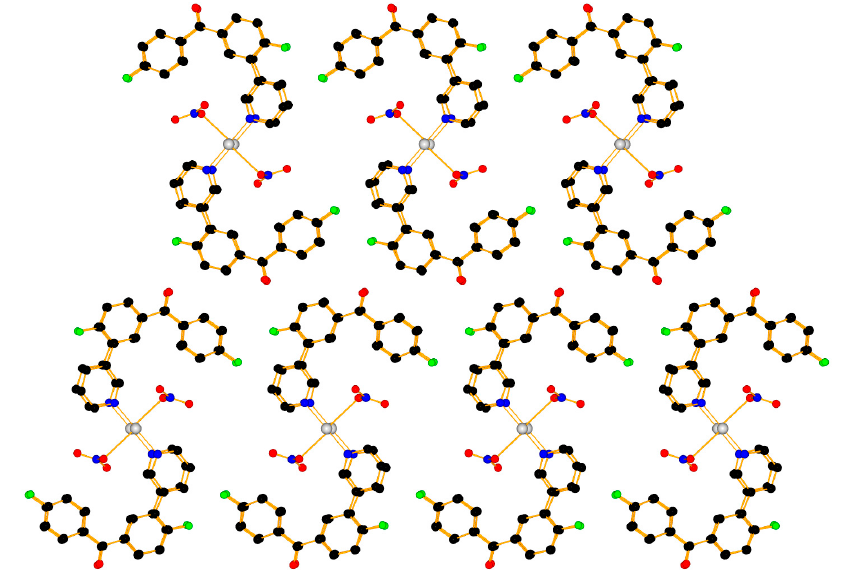
Figure 9. View of the packing of 5a . Hydrogen atoms were omitted for clarity. Different colors have been attributed to the different atoms (black: C, blue: N, red: O, yellow: P, green: F, grey: Ag).